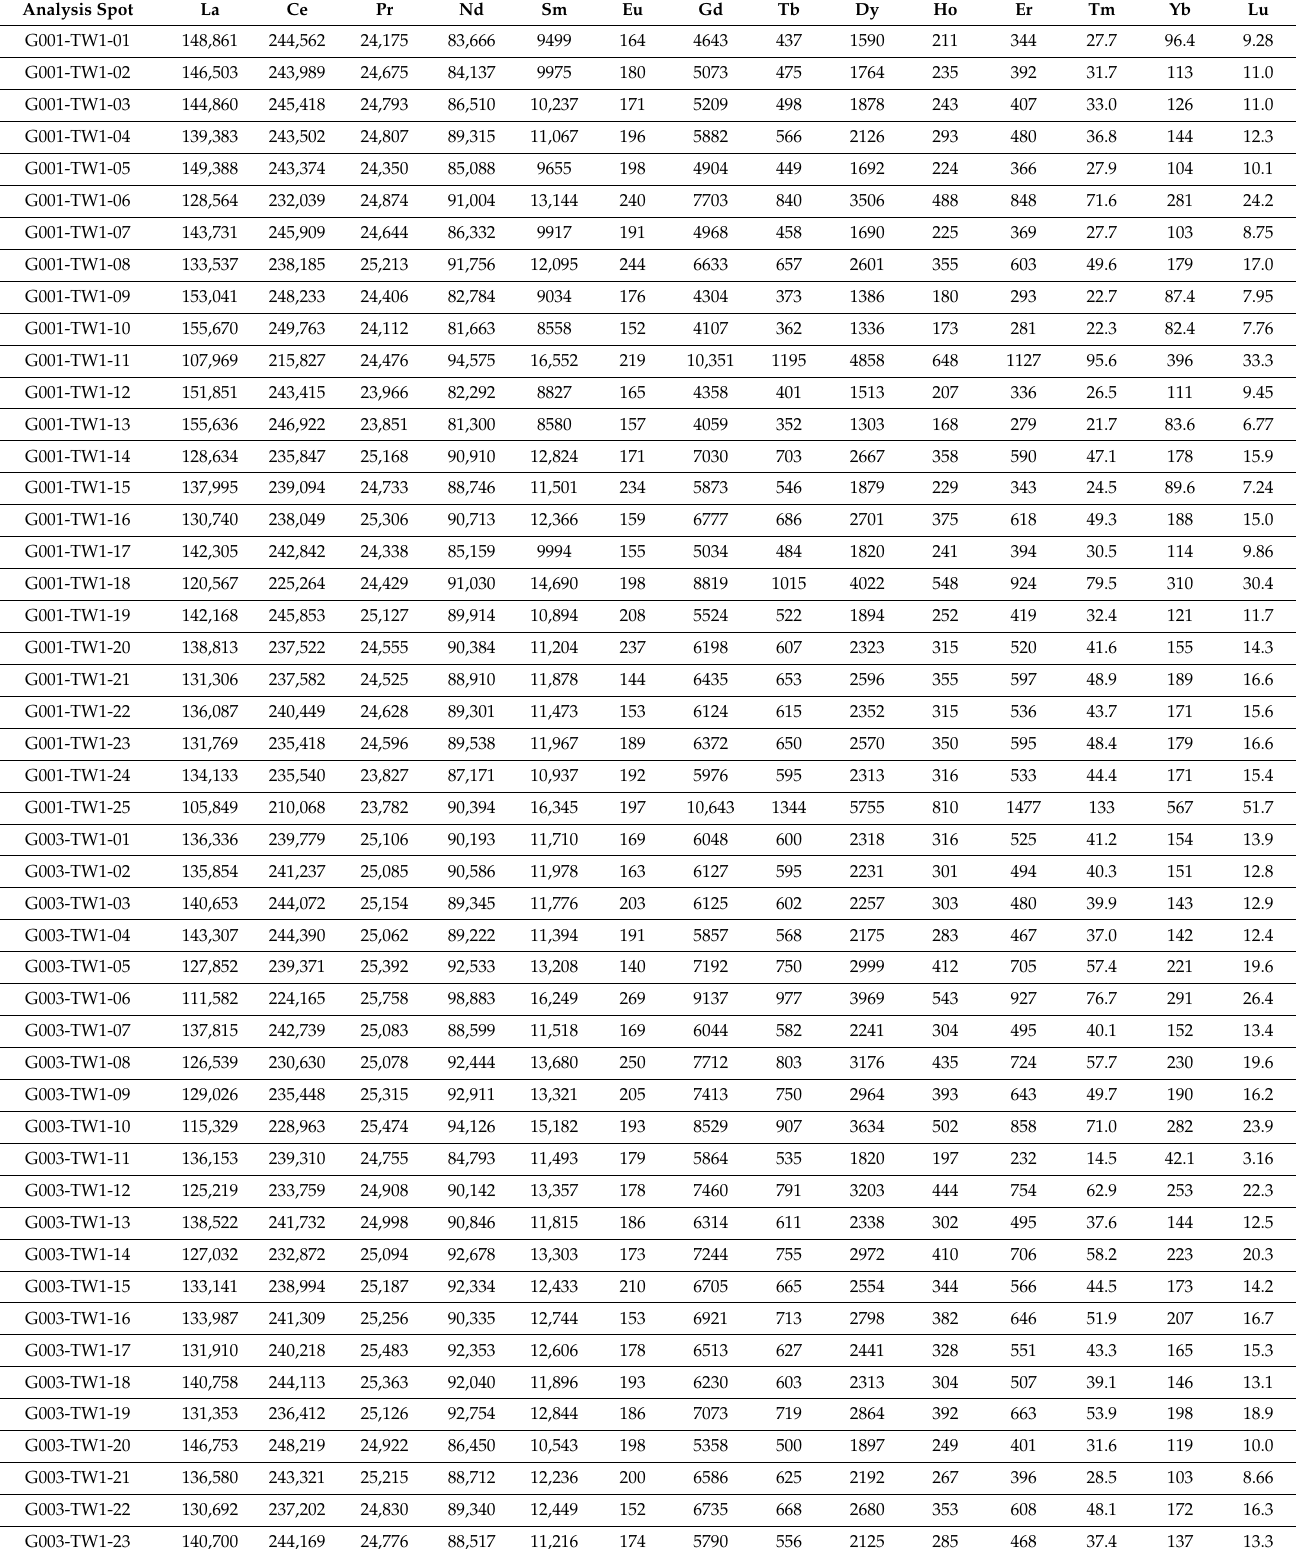
Table 3. LA-ICP-MS monazite rare earth elements data of Baishi granite ( × 10 − 6